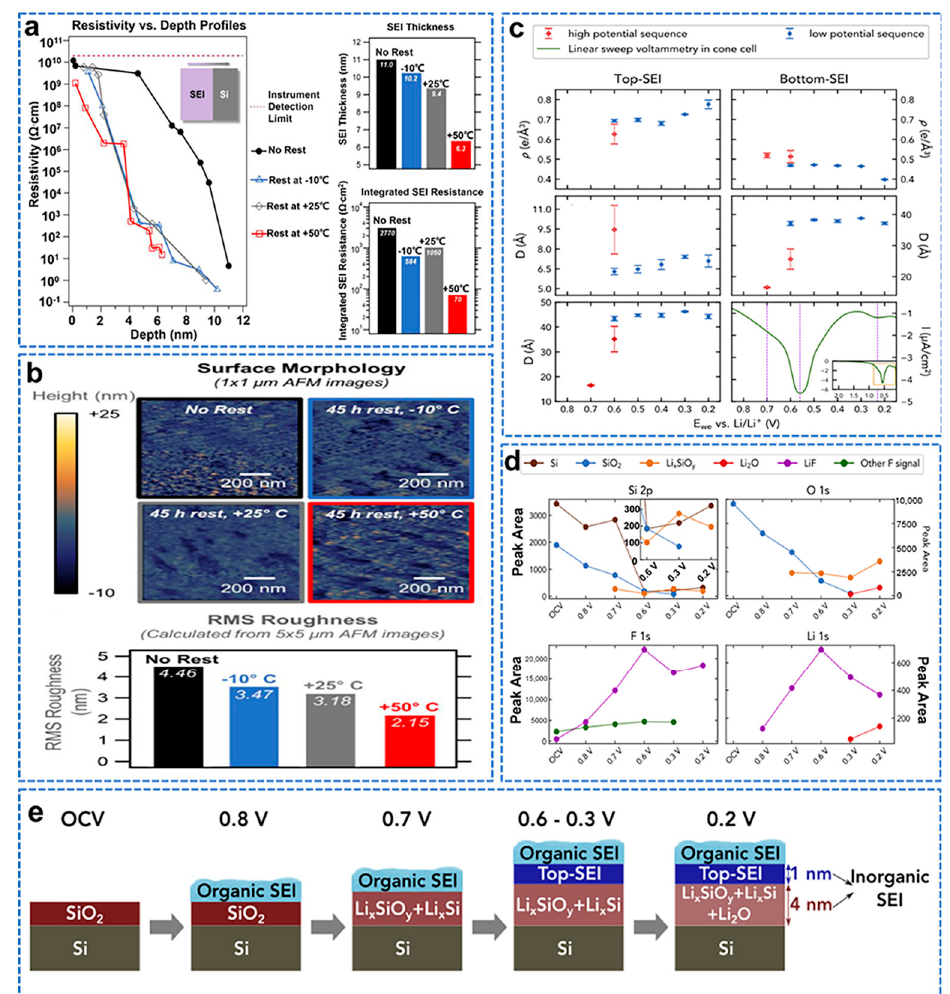
Figure 15. ( a ) Comparison of SSRM 3 − D resistivity vs. depth profiles, SEI thickness and integrated SEI resistance obtained from resistivity vs. depth profiles for SEI with varied resting protocols, ( b ) AFM images at 1 × 1 µm showing surface morphology of SEI with 50 cycles of SEI formation with varied resting protocols and RMS roughness from the same surfaces, calculated from larger 5 × 5 µm AFM images [139]. ( c ) Best − fit results of XRR datasets of high − potential (red markers) and low − potential (blue markers) sequence experiments, ( d ) Voltage − dependent XPS fit − derived peak areas corresponding to Si 2p, O 1s, F 1s, and Li 1s spectral ranges, ( e ) Schematic illustration of the proposed potential − dependent SEI growth mechanism on native oxide − terminated Si anodes